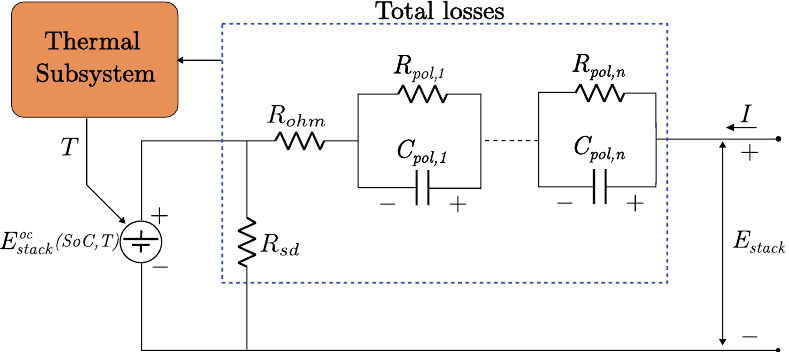
Figure 5. Equivalent electric circuit model of a